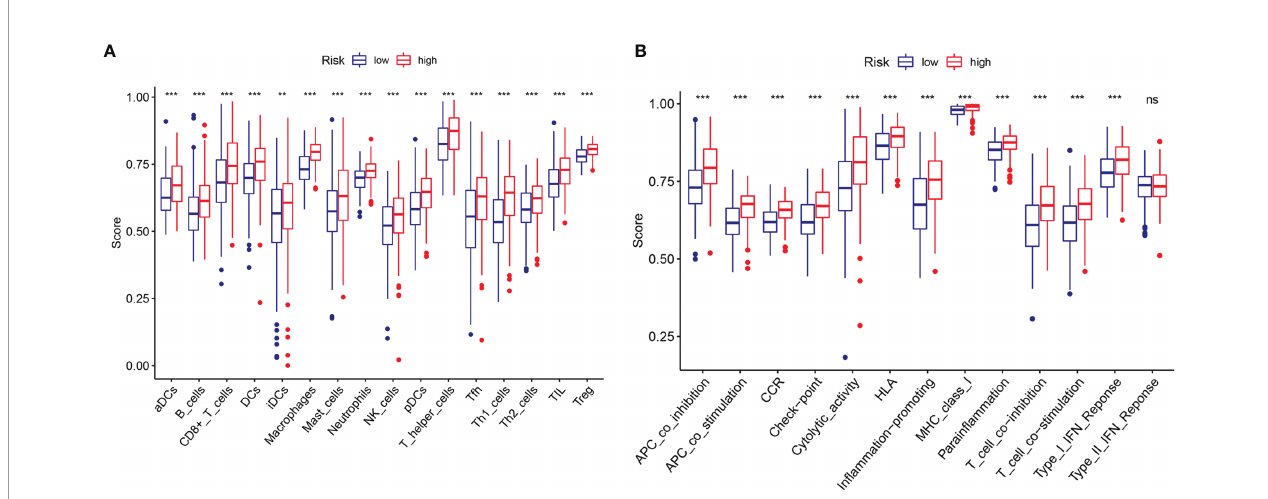
FIGURE 8 | Comparison of the ssGSEA scores between the high- and low-risk groups. The scores for 16 immune cells (A) and 13 immune-related functions (B) are displayed in boxplots. ns, not signi fi cant. ** P <0.01; *** P